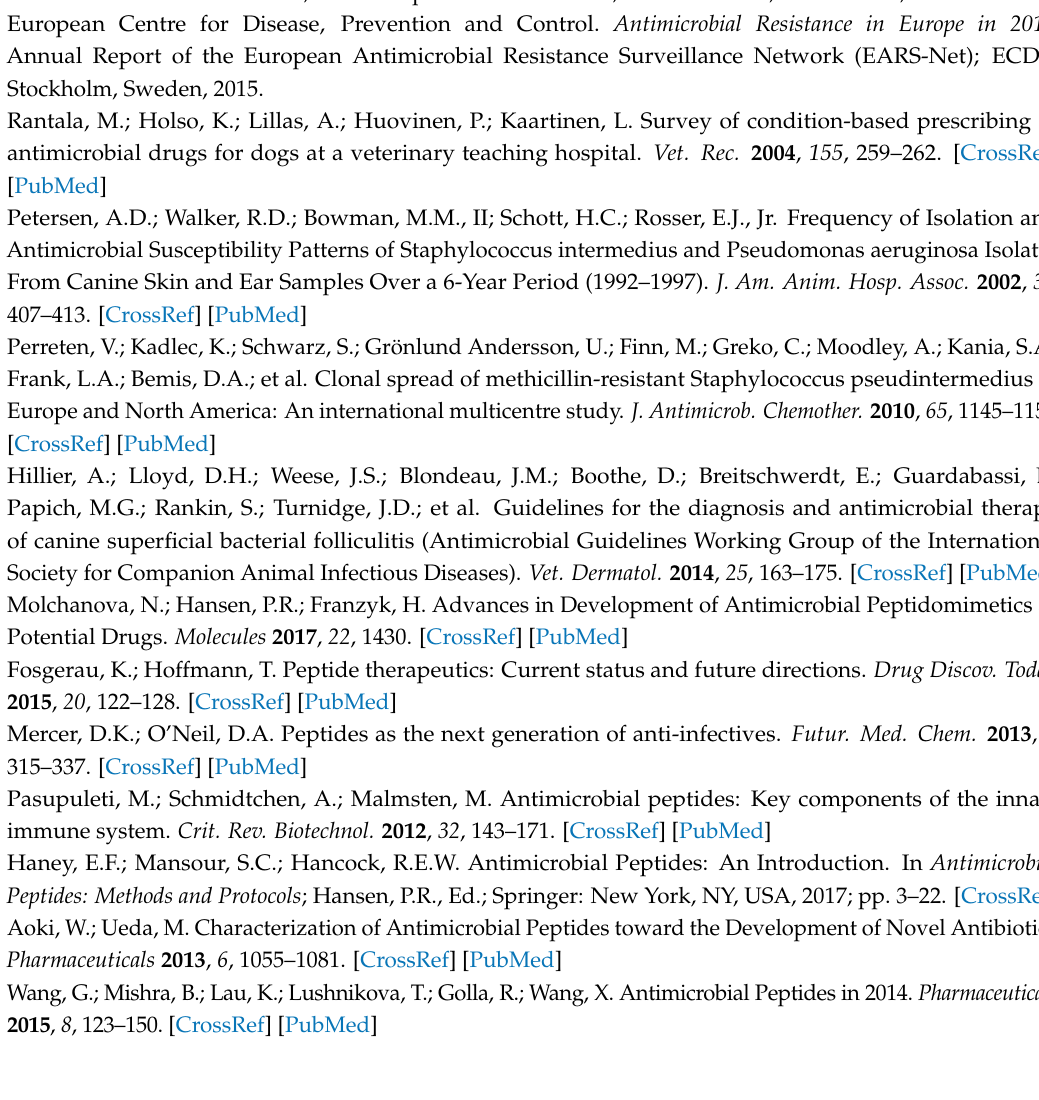
Supplementary Materials: Supplementary materials are available on line. Table S1: Gradient elution used for purification of compounds on preparative RP-HPLC. Table S2: Gradient elution used for analytical RP-HPLC , Table S3: Retention times, peak areas and relative peak areas of D2 as detected by RP-HPLC., Table S4: Final gradient elution UV-UPLC method used for the LC-MS/MS experiments., Table S5: Half-lives of peptide-peptoid hybrid B1 and peptoid D2 measured after 60 minutes of incubation at 37 ◦ C with dog plasma; Figure S1: Analytical HPLC chromatogram of compound B1, Figure S2: MALDI-TOF MS spectrum of B1, Figure S3: Analytical HPLC chromatogram of compound D2, Figure S4: MALDI-TOF MS spectrum of D2, Figure S5: Stability of D2 to pronase E, Figure S6: B1 in 50% Transcutol in acetate buffer pH 5 detected via UV-UPLC (day 0), Figure S7: B1 in 50% Transcutol in acetate buffer pH 5 detected via UV-UPLC (Day 1), Figure S8: Concentration-time profile in plasma of the compounds B1 and